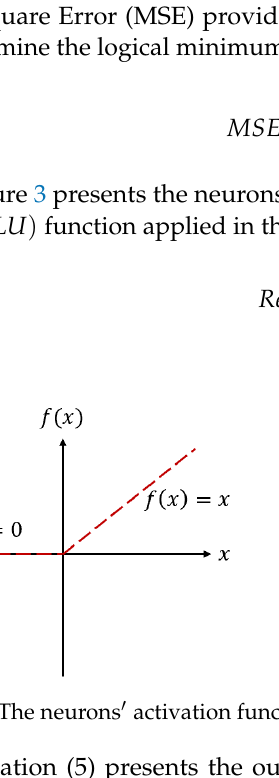
Figure 4. Loss function, MSE. 3.3. Model Evaluation Method To verify the regression equations ’ accuracy of fit in the multilinear regression method, we applied the Mean Square Error (MSE), as shown in Equation (7).